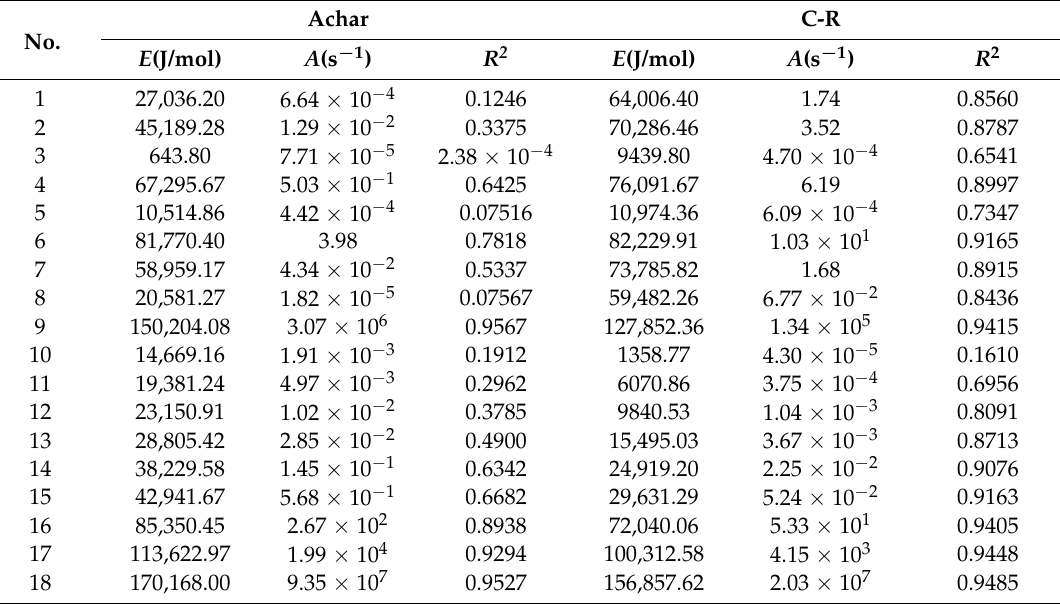
Table 4. E , A , and R 2 of pulverized coal combustion with the forty-one mechanism functions.